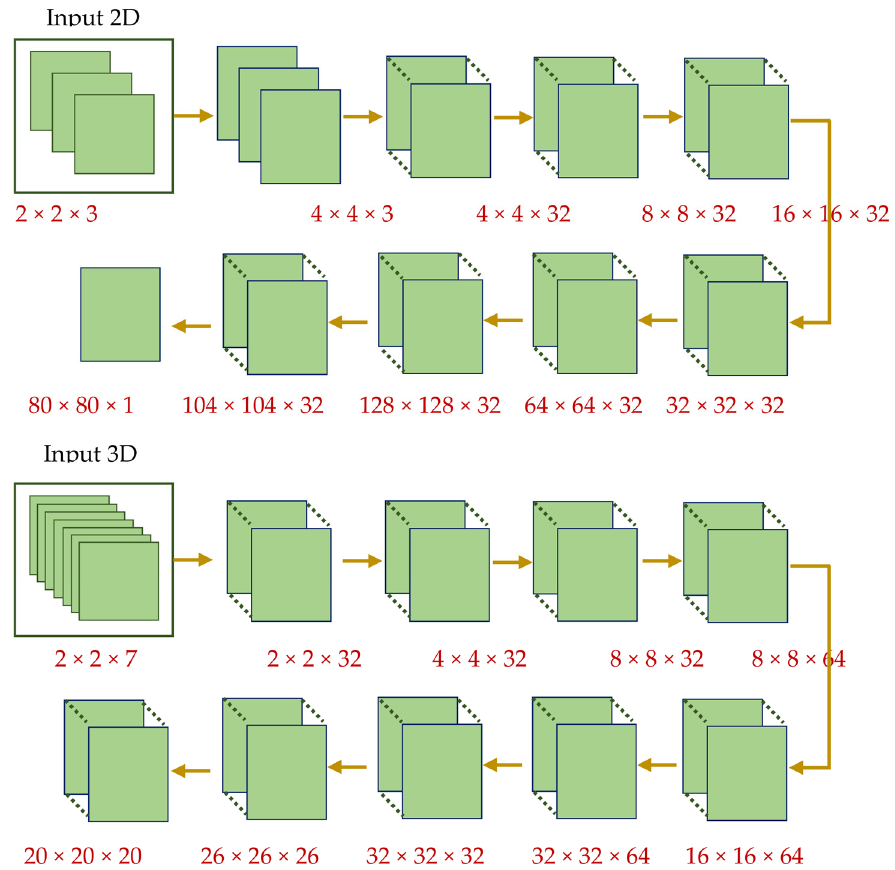
Figure 5. Visual representation of CNN modules for 2D and 3D objects.